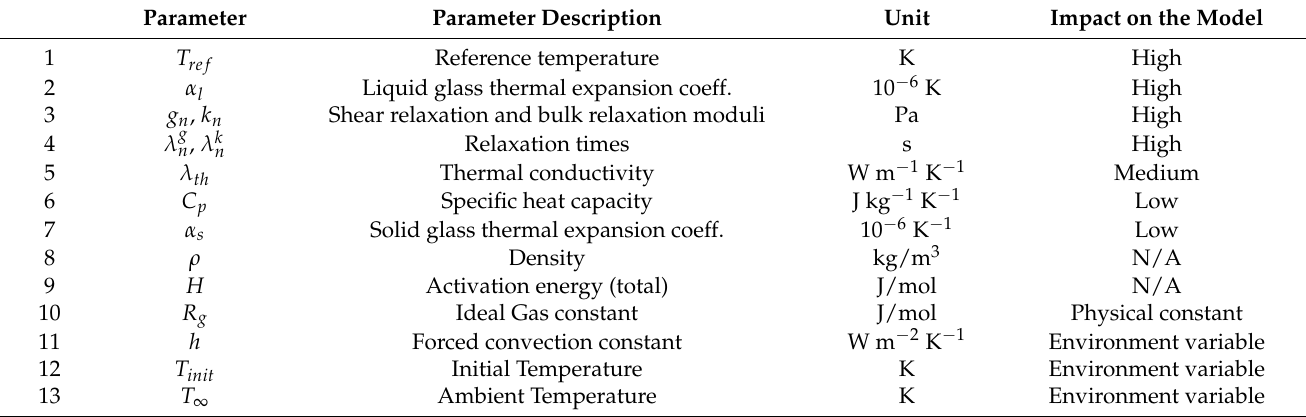
Table 1. Summary of model parameters and impacts acc. to Daudeville and Carre